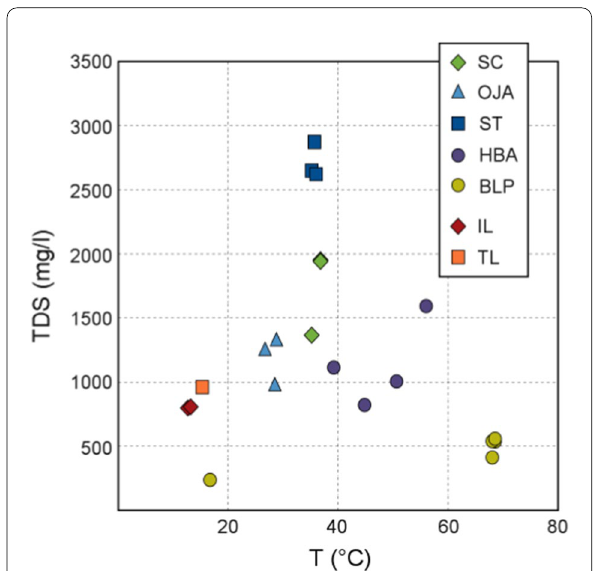
Fig. 7 Temperature vs Total Dissolved Solids (TDS) for the thermal spring waters ( SC San cayetano, ST Santa Teresita, OJA Ojo de Agua, BLP Bajo Las Peñas, HBA Hervideros de Buenos Aires) and Irazú– Turrialba lake waters ( IL Irazú lake, TL Turrialba lake)